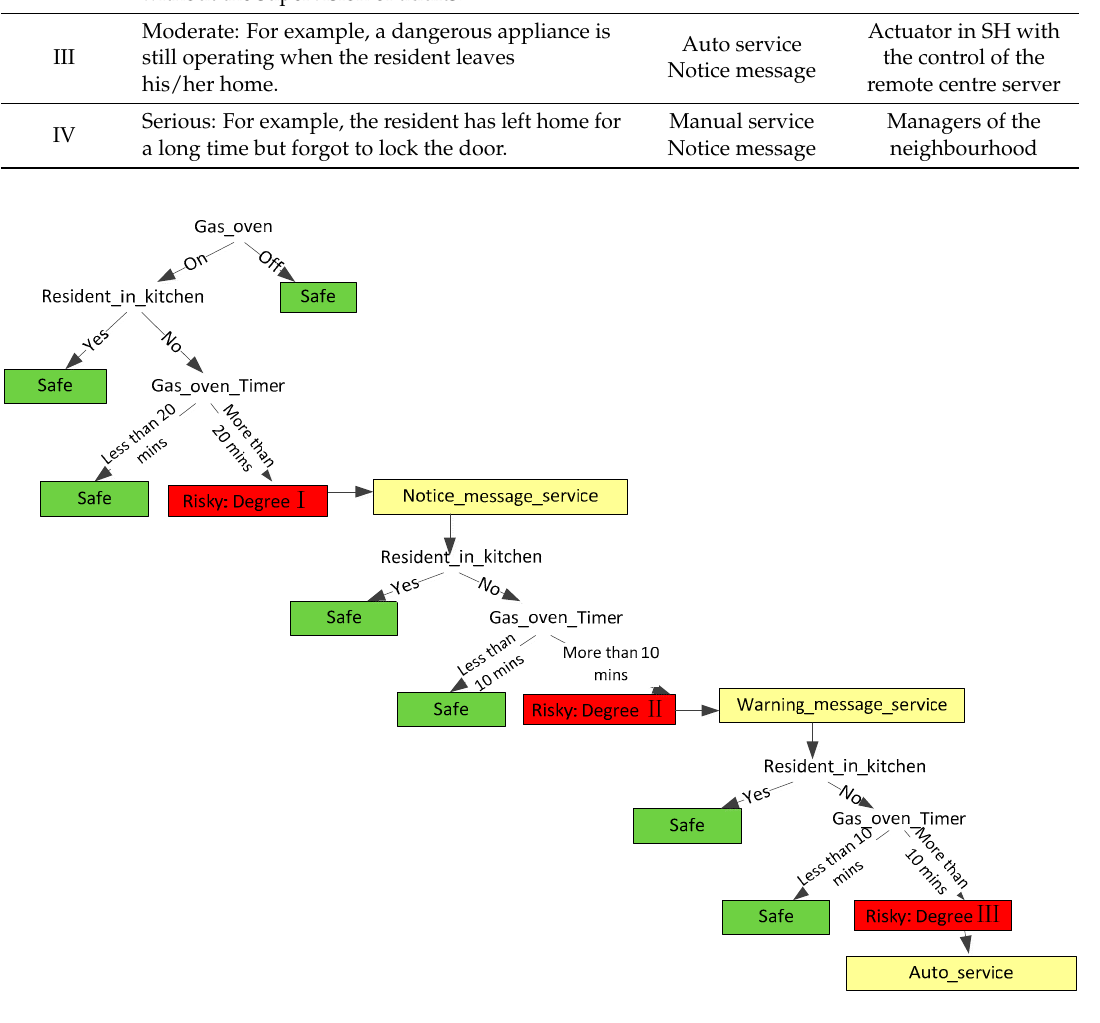
Figure 12. The Structure of Risk DT.